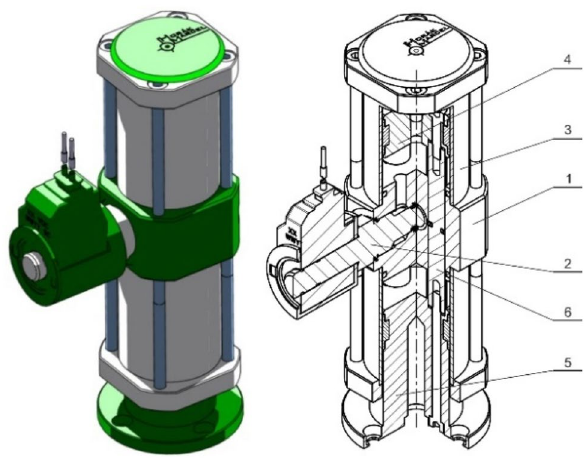
Fig. 29 Fluid position compensator